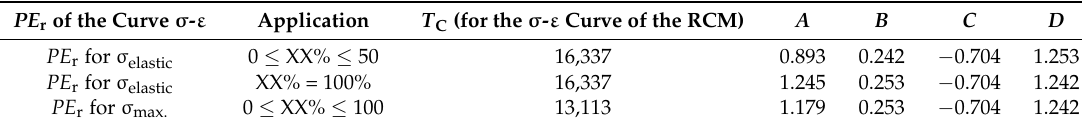
Table 7. Values of the constants for each of the curves.